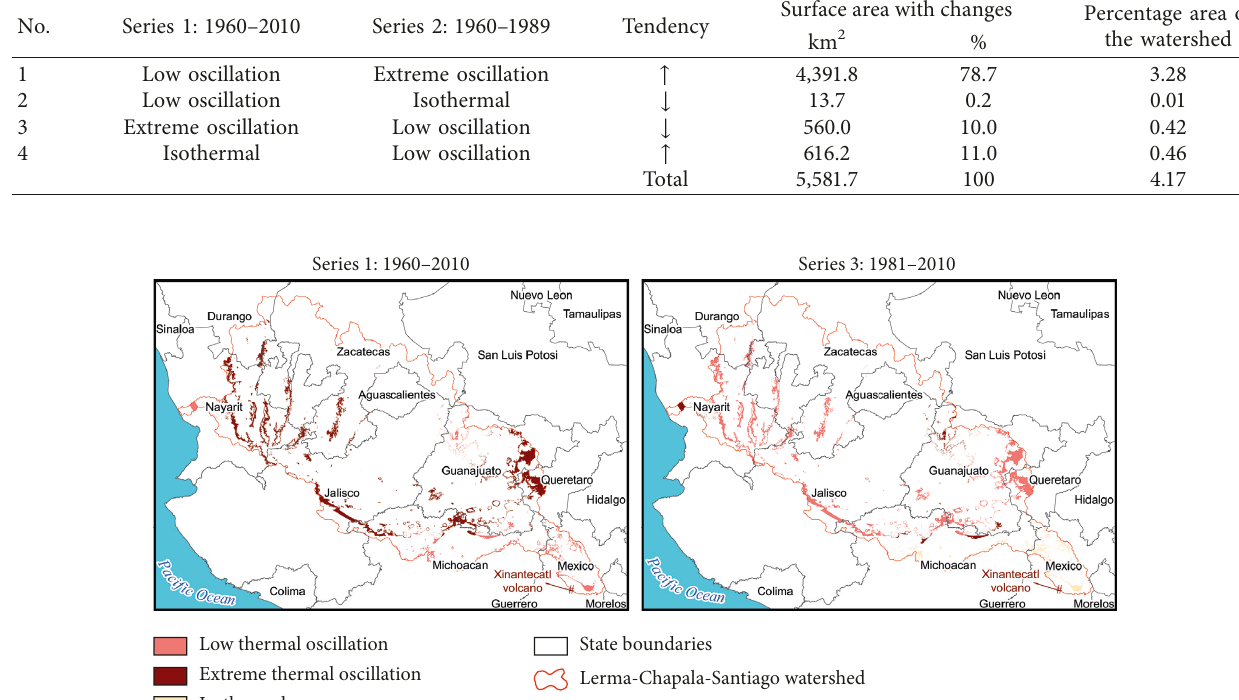
Figure 8: Areas of the watershed with changes in thermal oscillation between time series one (1960–2010) and time series three (1981–2010).